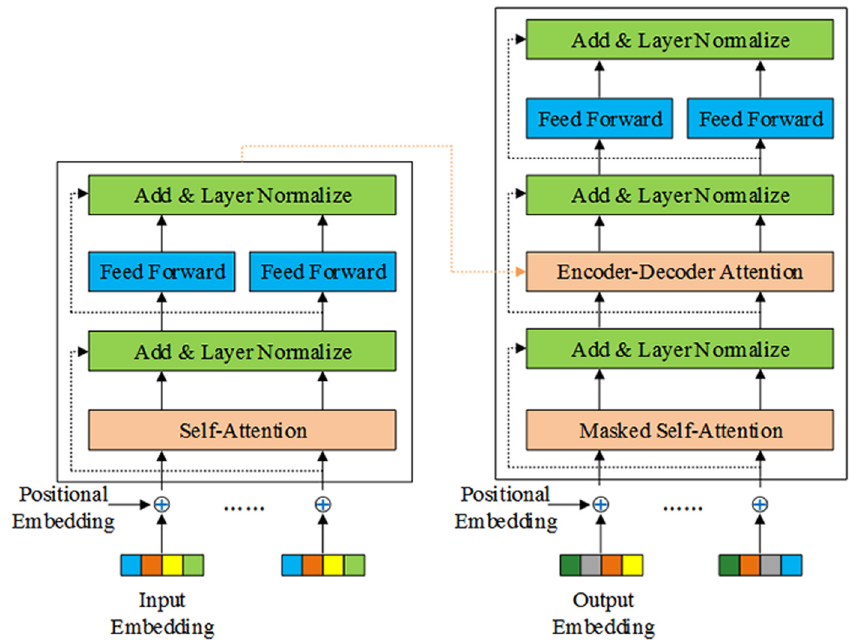
Figure 1: General transformer model